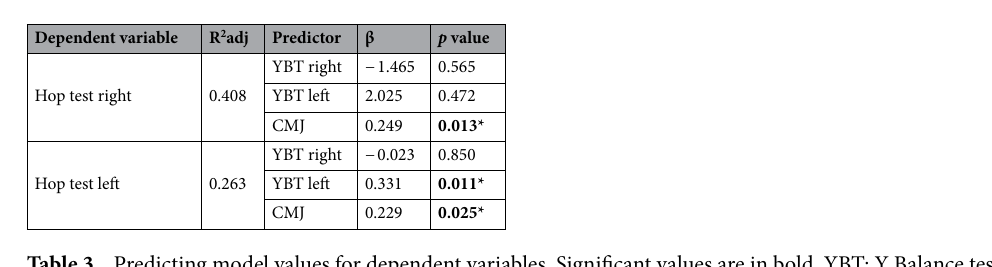
Table 3. Predicting model values for dependent variables. Significant values are in bold. YBT: Y Balance test; CMJ: Counter Movement Jump. * indicates p vales <